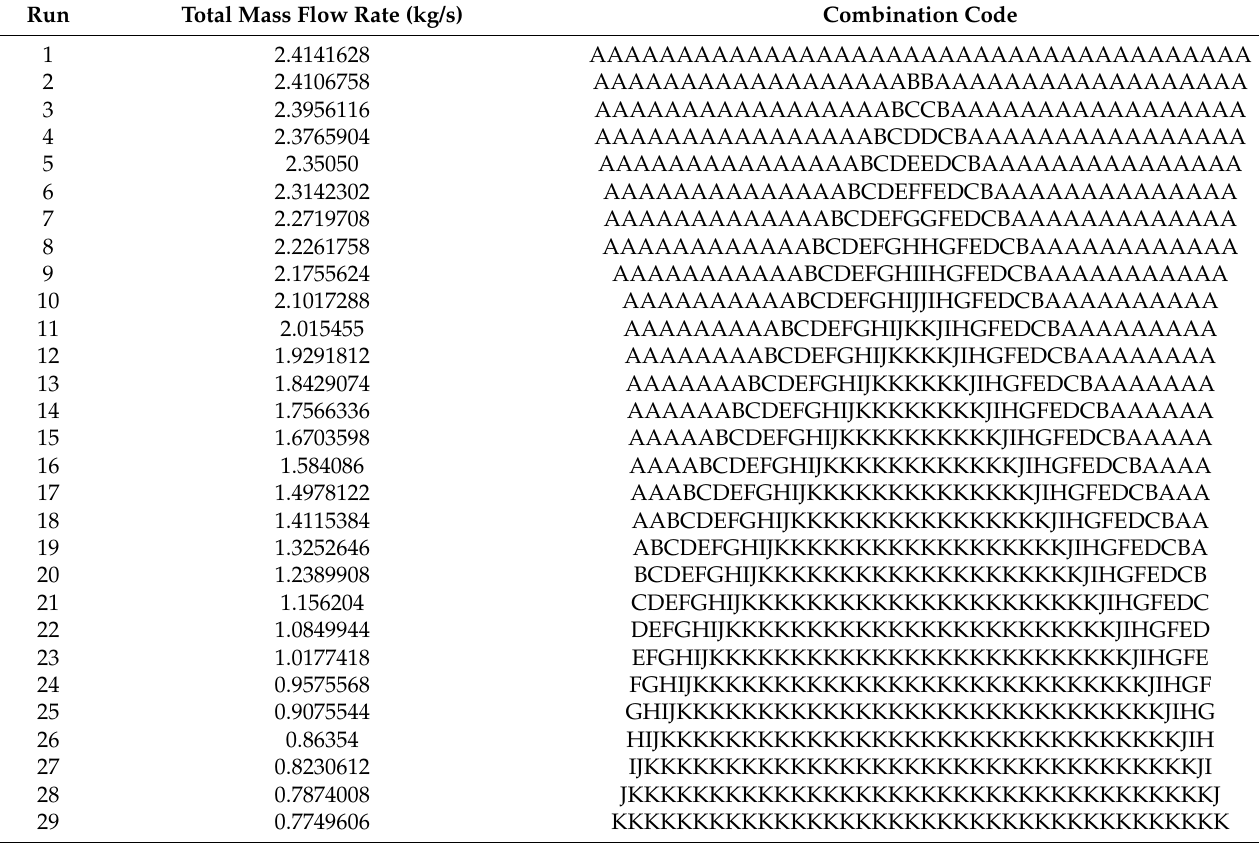
Table 2. Combinations of mass flow rates for one stall